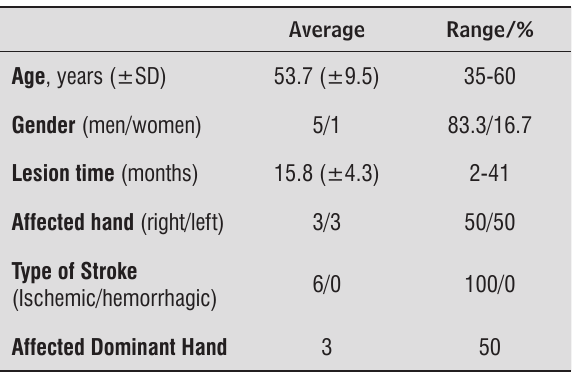
Table 1 - Characteristics of the